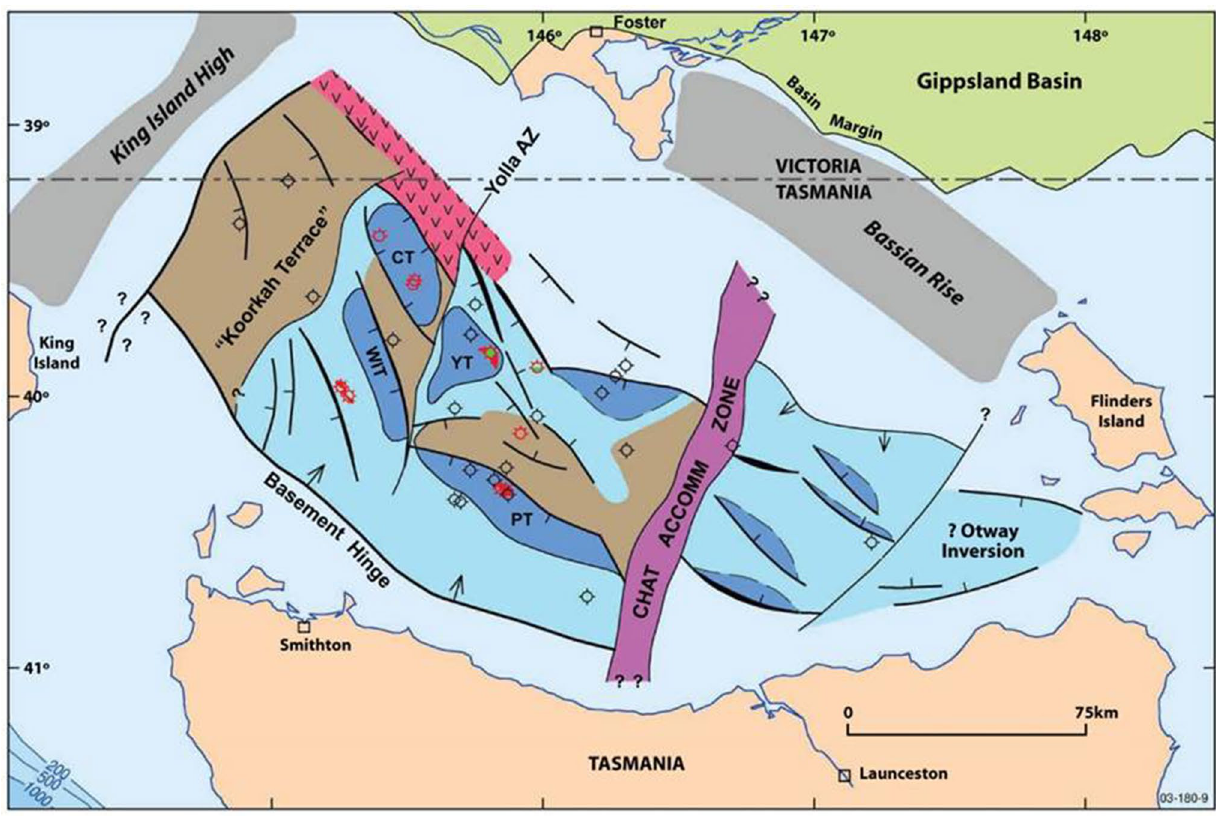
Fig. 2 Regional map showing the location of tectonic elements and generalized basement fault trends in the Bass Basin (Blevin et al. 2003). Cor- morant (CT), Yolla (YT), White Ibis (WIT), Pelican troughs (PT) and the Chat Accommodation Zone